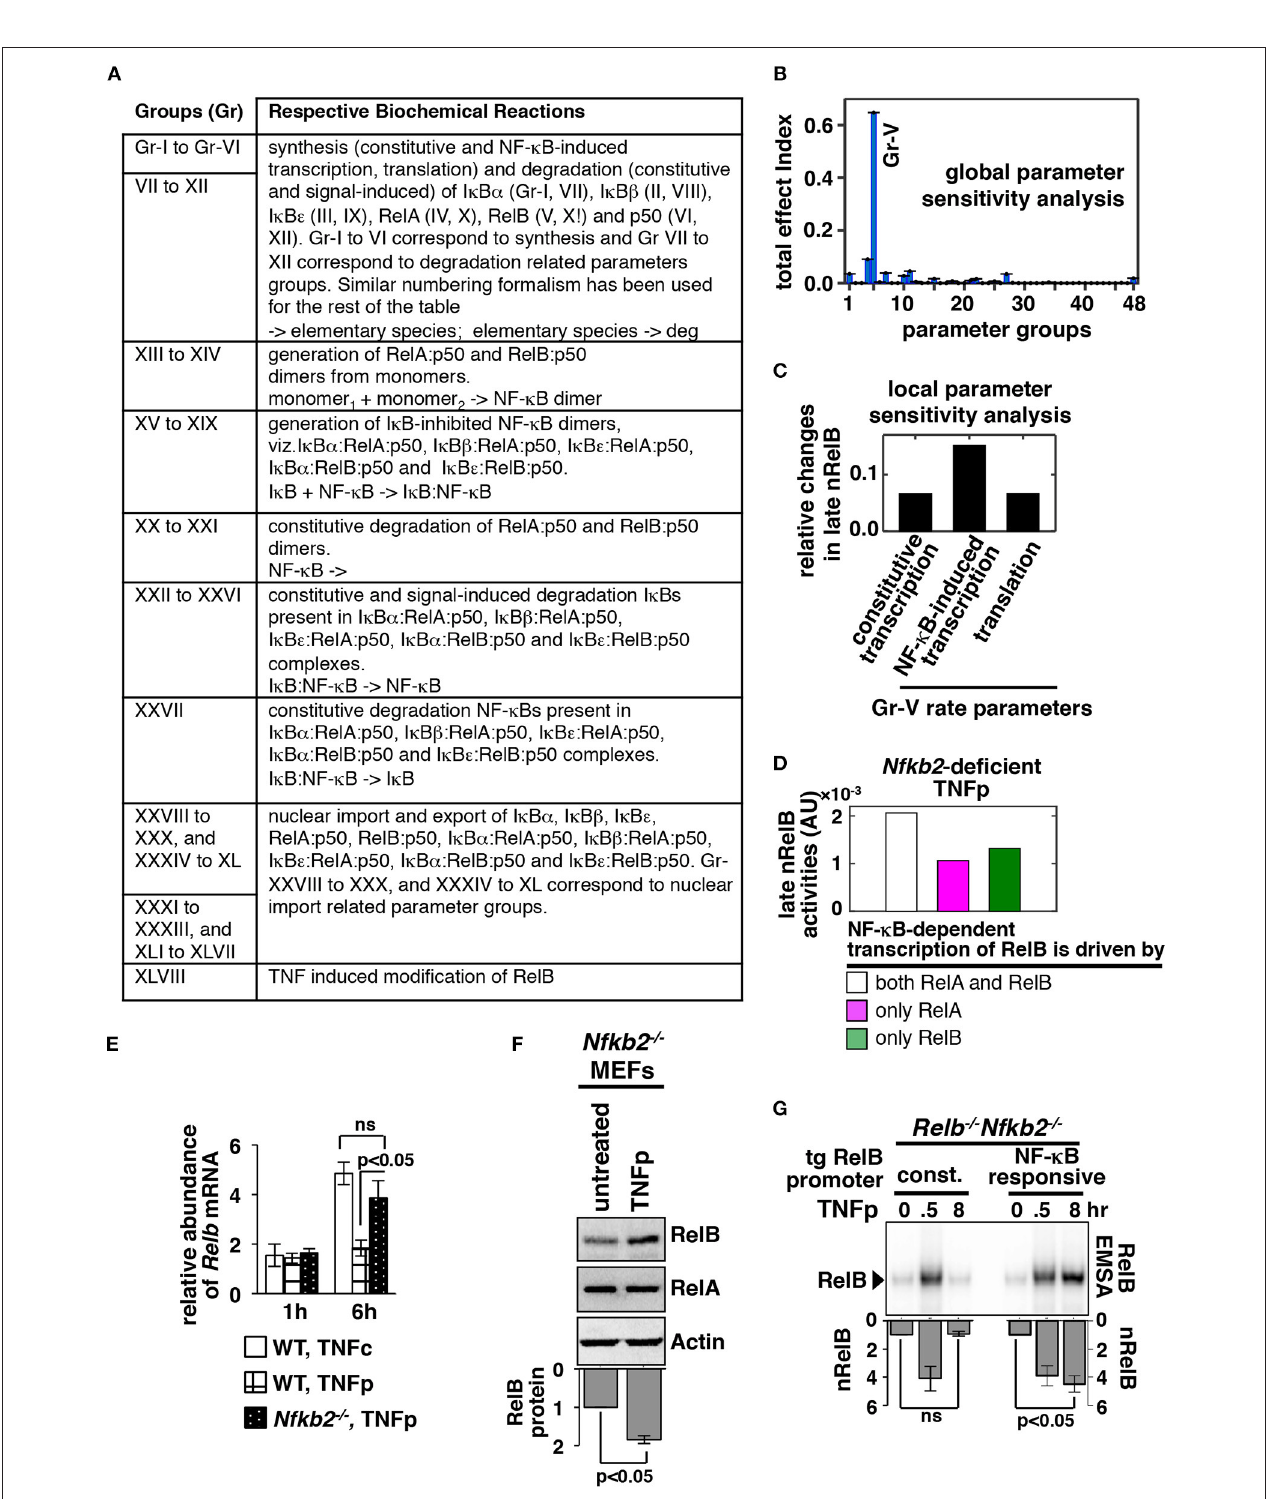
FIGURE 3 | NF- κ B-dependent RelB synthesis promotes the late RelB:p50 activity induced upon brief TNF treatment of Nfkb2 − / − cells. (A) Parameter groups analyzed in the variance-based, multiparametric sensitivity analysis. (B) Variance-based multiparametric analysis revealing the total effect index, which represent the effect of the parameter uncertainty on the late (6–8h) RelB:p50 activity induced by TNFp in the Nfkb2 -deficient system for the individual parameter groups. Standard bootstrapping was used for estimating error ranges. Gr, group. Gr-V consists of parameters related to RelB synthesis; including constitutive and NF- κ B induced transcriptions as well as translation. (C) Local sensitivity analysis revealing the effect of 10% increase in the indicated parameters belonging to Gr-V on the late